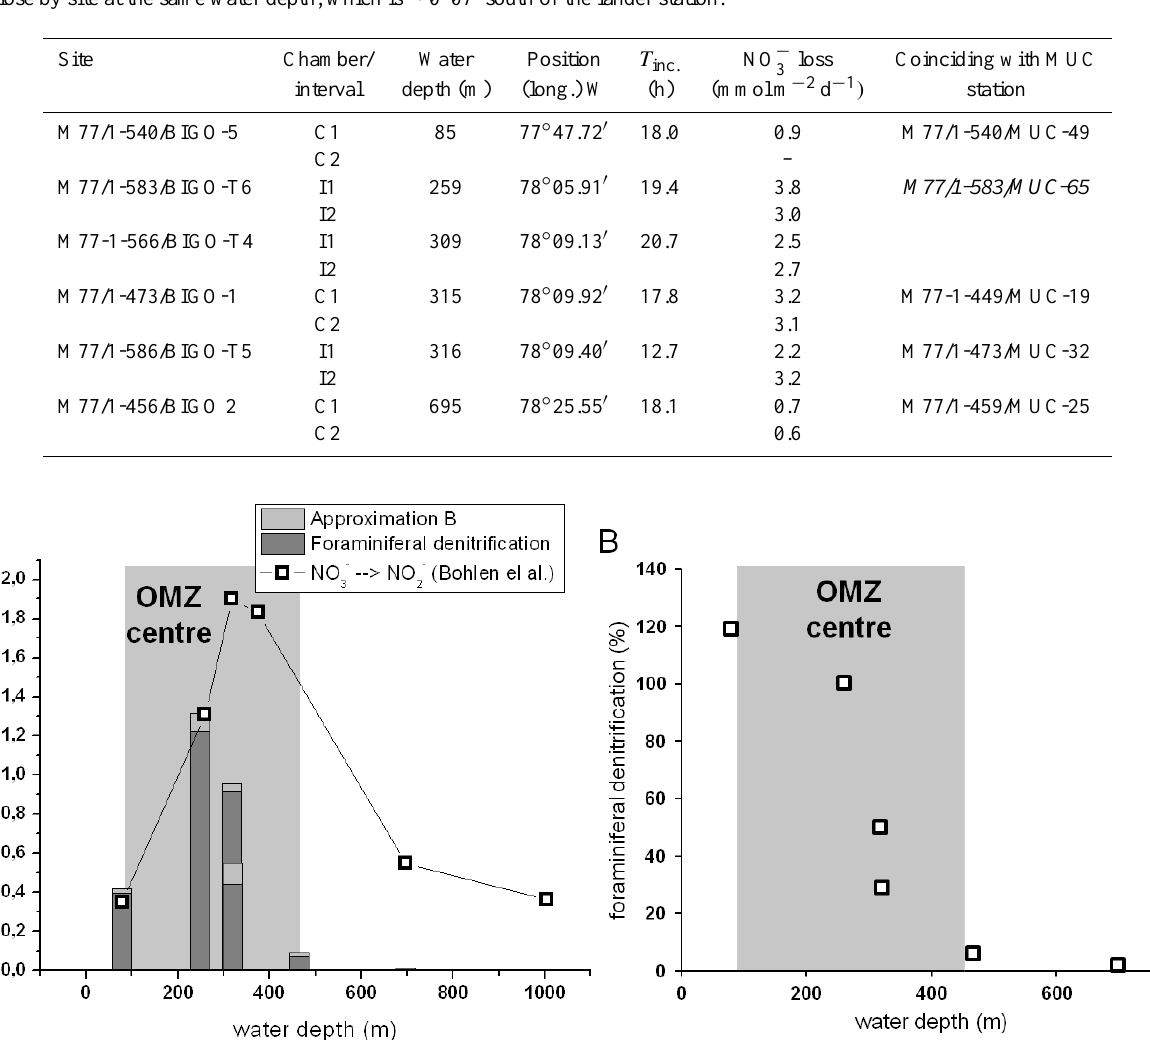
Fig. 2. (A) Comparison of benthic foraminiferal denitrification rates and modelled turnover rates from NO − Figure 2: A : Comparison of benthic foraminiferal dentrification rates and modeled turnover both plotted against water depth. (B) Percentage of the contribution of foraminiferal denitrification to the total benthic NO − rates from NO 3- to NO 2- (Bohlen et al., 2011) both plotted against water depth. of the contribution of foraminiferal denitrification to the total benthic NO denitrification.